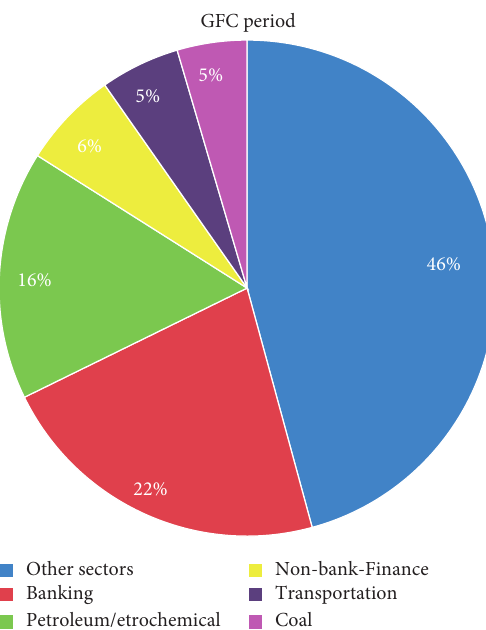
Figure 5: CES in the GFC period